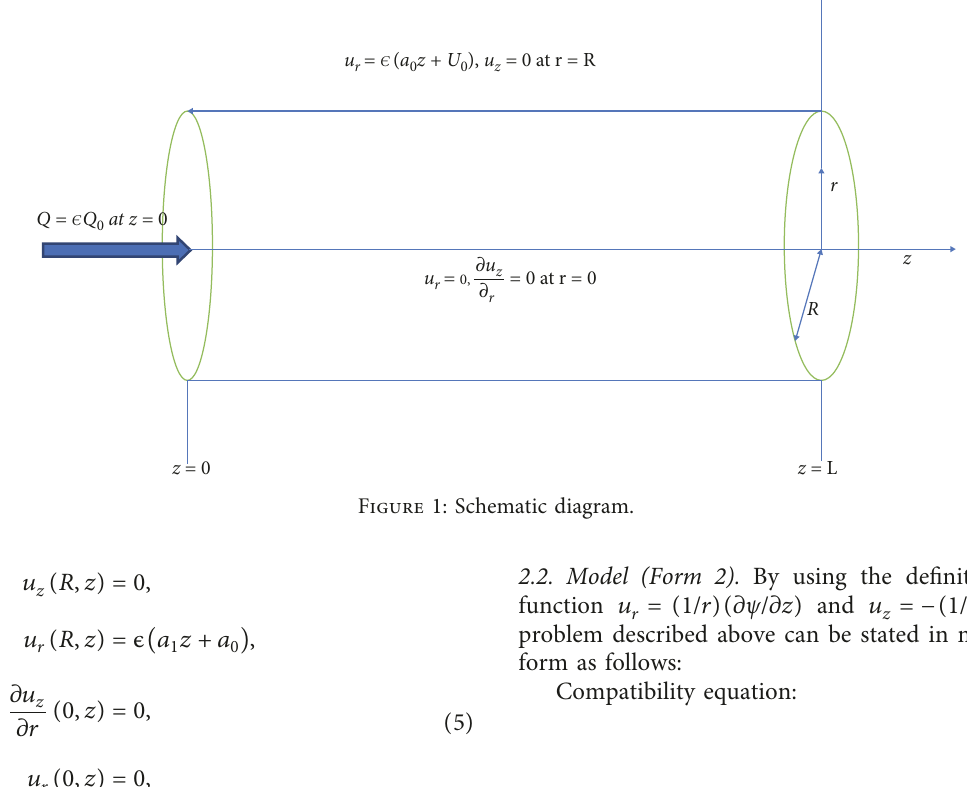
Figure 1: Schematic